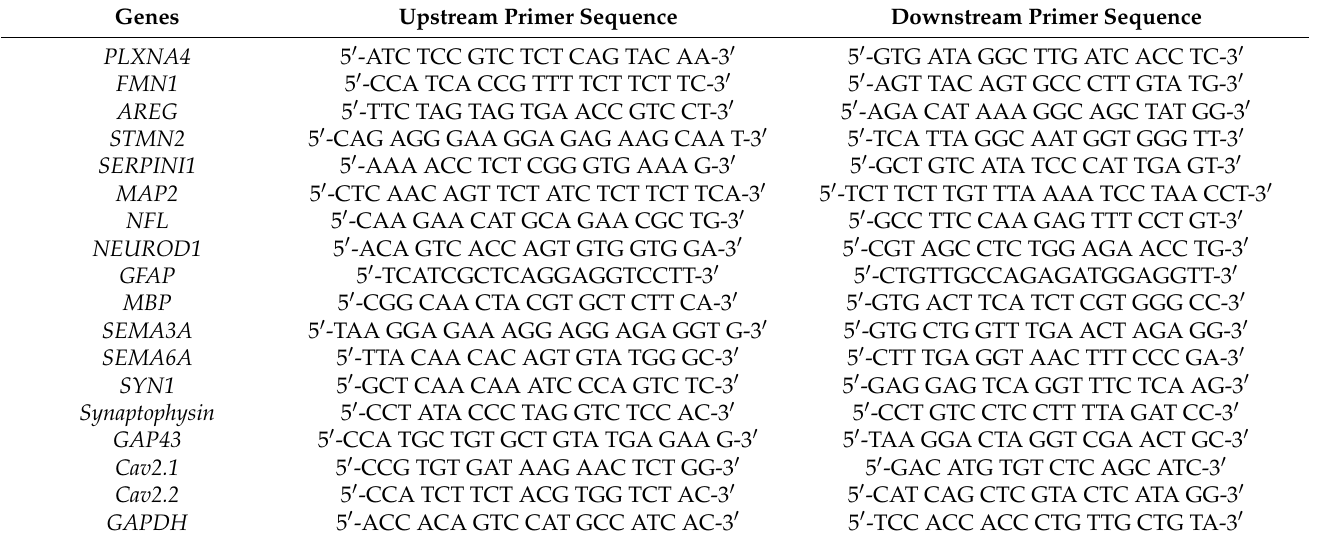
Table 1. Primer sequences used for